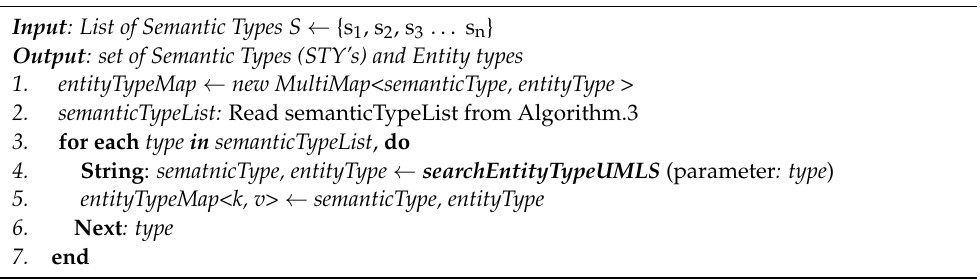
Algorithm 4 : Entity-Type Identification from